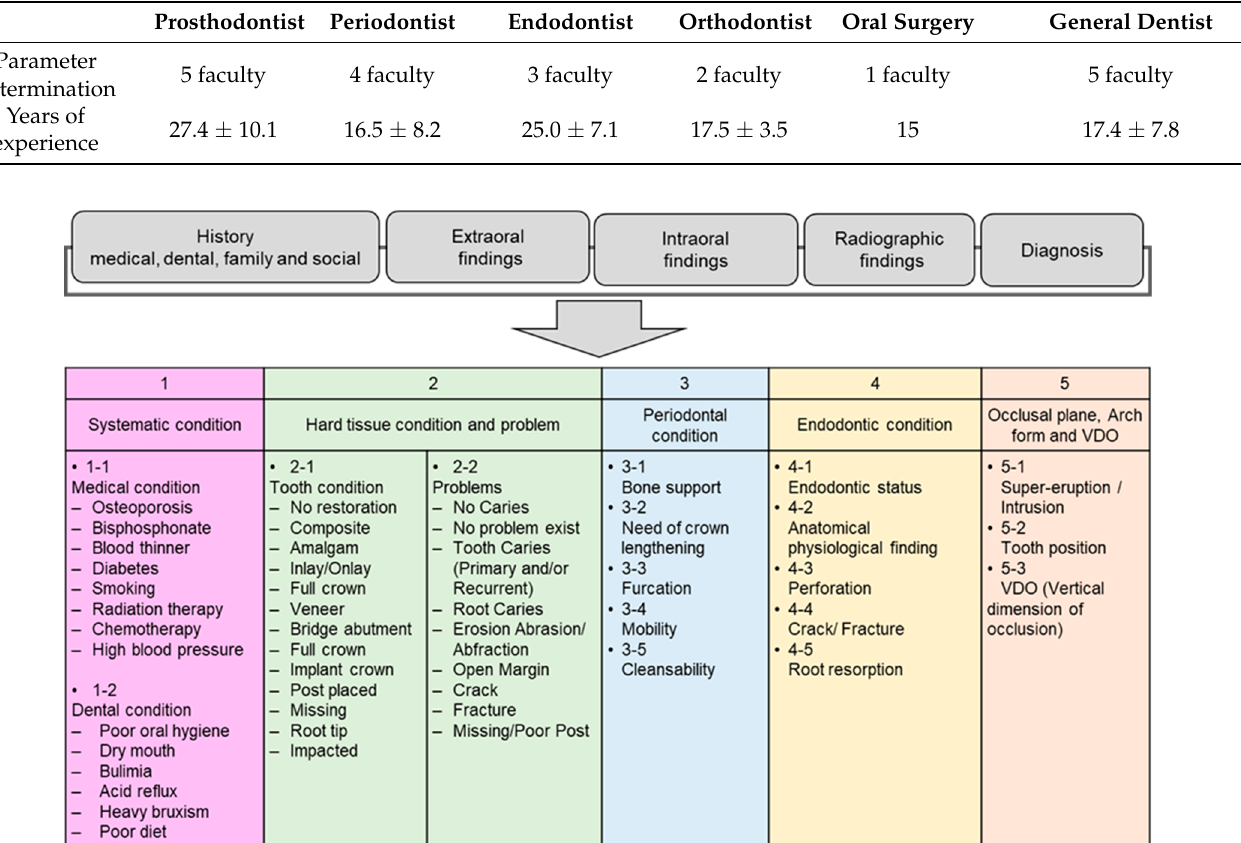
Table 1. Discipline distribution of participants for clinical parameter determination (mean ± SD).